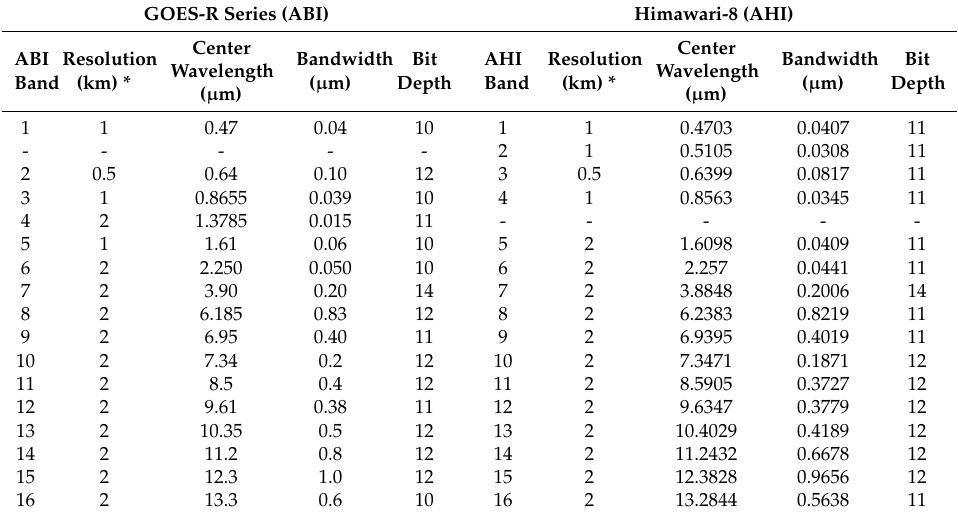
Table 1. Advanced Baseline Imager (ABI) and Advanced Himawari Imager (AHI) spectral channels match very closely except for a green channel (AHI Band 2) that ABI lacks and a NIR water vapor absorption band (ABI Band 4) that AHI lacks. Their common Bands 5 also have di ff erent resolutions. ABI bands are as specified, and Himawari-8 AHI as measured. GOES-R Series (ABI) Himawari-8